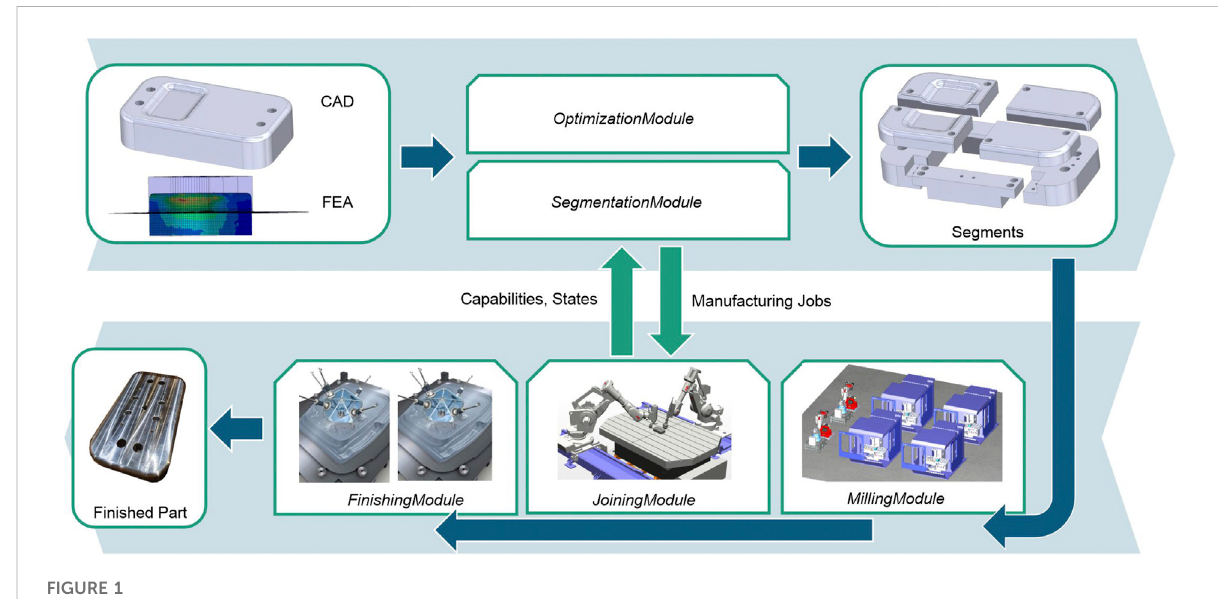
FIGURE 1 Overview of the approach and the underlying process